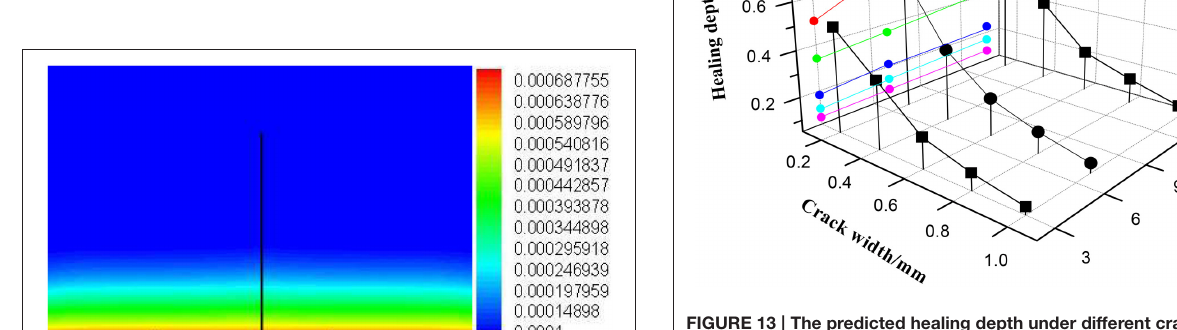
FIGURE 13 | The predicted healing depth under different crack width after different healing time.